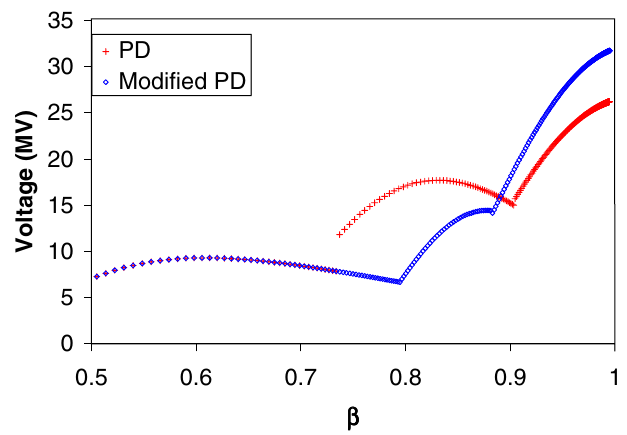
FIG. 4. (Color) Voltage gain per cavity as a function of particle relative velocity. The crosses correspond to the existing PD design reported in Ref. [3], the diamonds show the voltage gain in the modified PD with 8 (cid:1)= 9 -mode